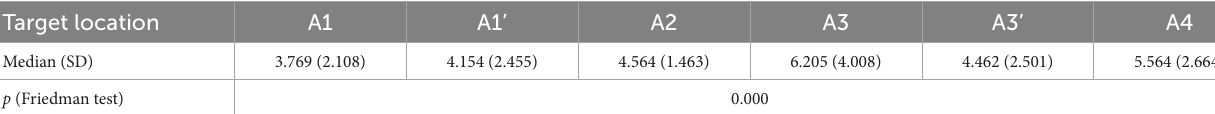
TABLE 10 Results of the fixation count along the different locations.